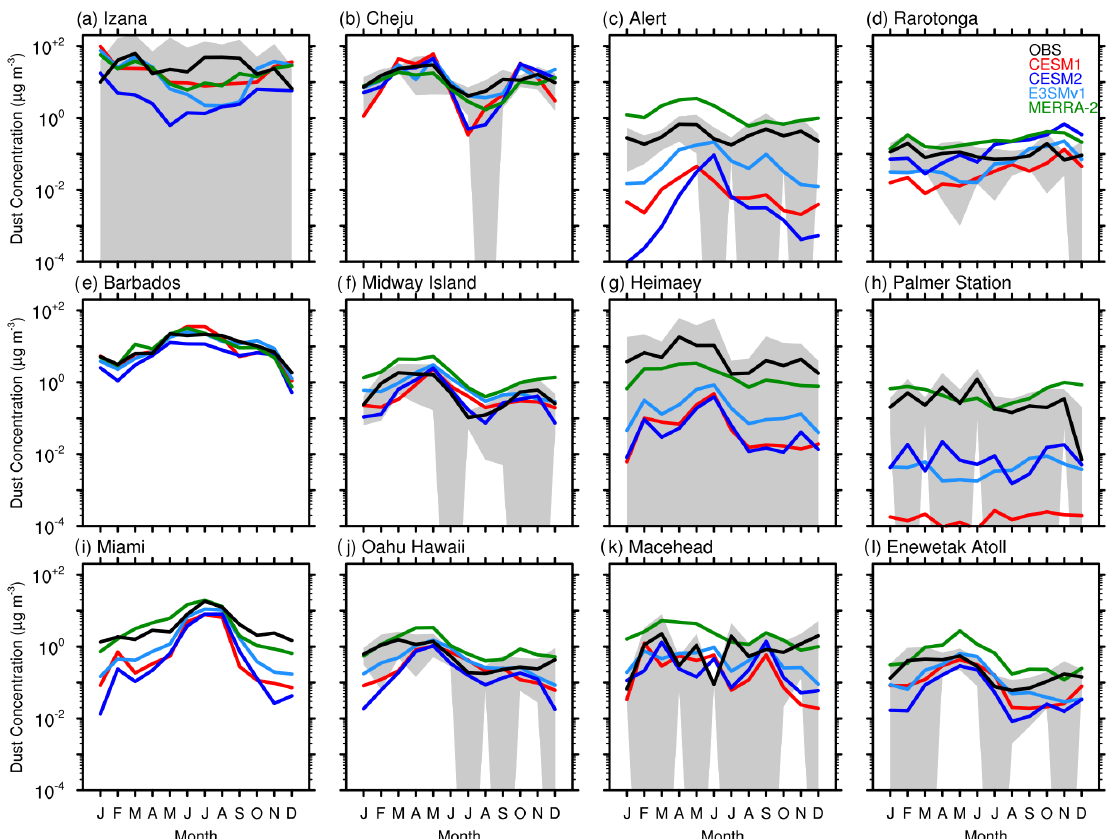
Figure 10. Seasonal variations of dust surface concentrations (µgm − 3 ) from model simulations and ground measurements at 12 selected sites. Shaded areas are for ± 1 standard deviation of